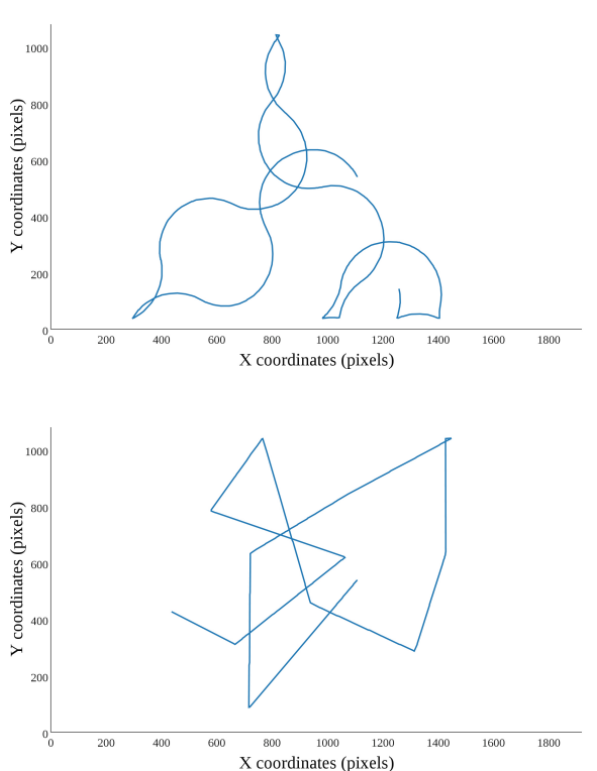
Figure 2: Curved lines (top) and straight lines (bottom) maneuvering types.